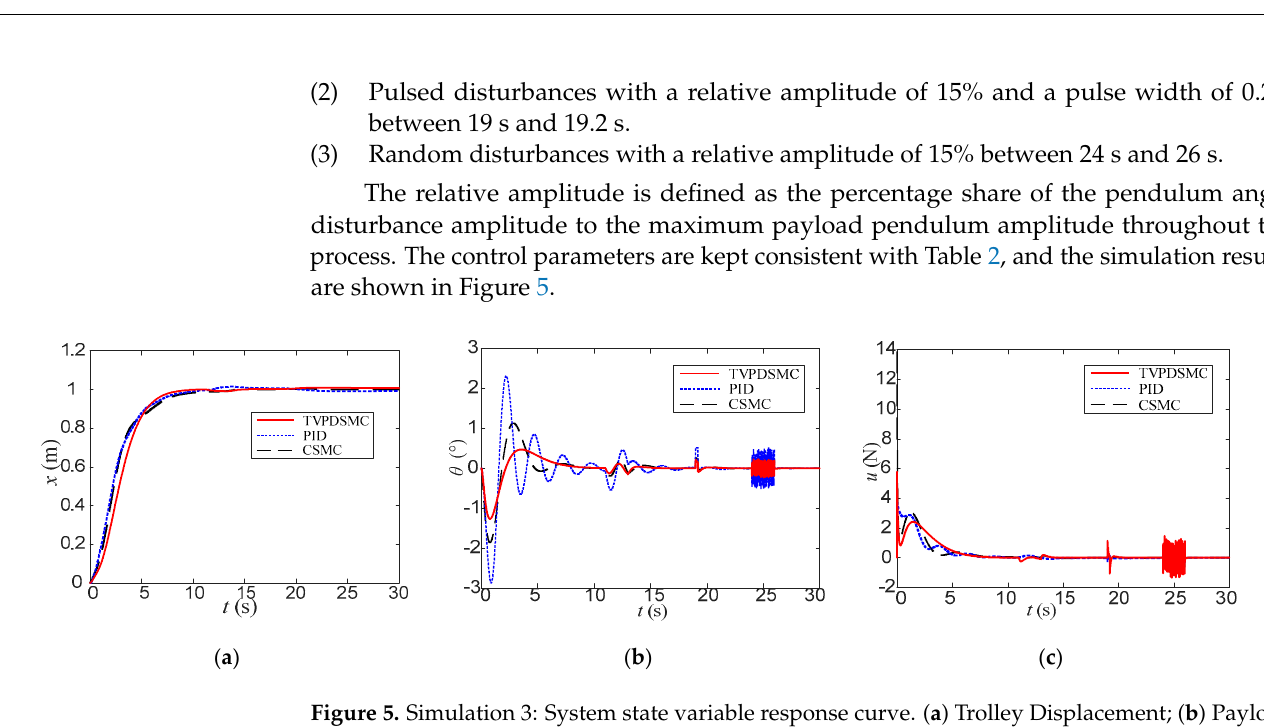
Swing angle; ( c ) Driving force.